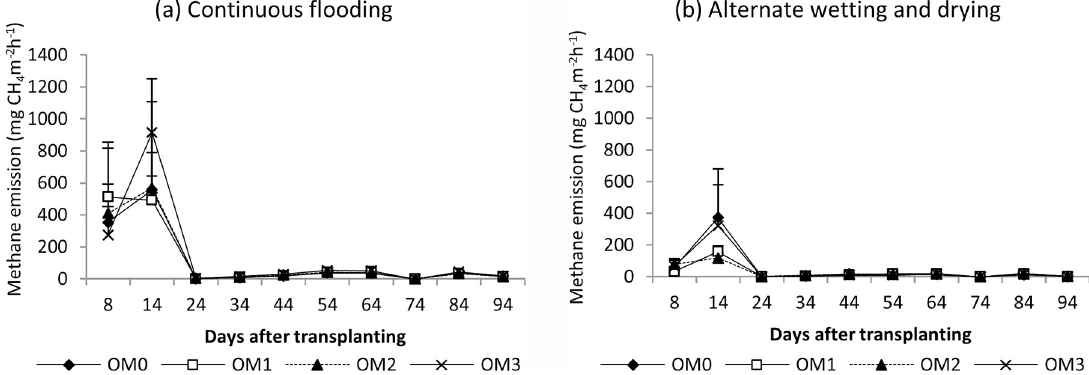
Fig 6. Methane emission from rice under (a) continuous flooding and (b) alternate wetting and drying during the dry season, 2017. Mean value ± standard deviation (n = 3).